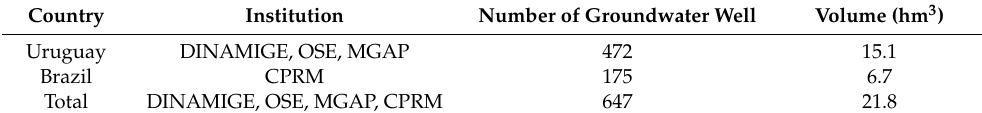
Table 3. Number and total demand for groundwater extraction well in the Cuareim / Quara í basin.